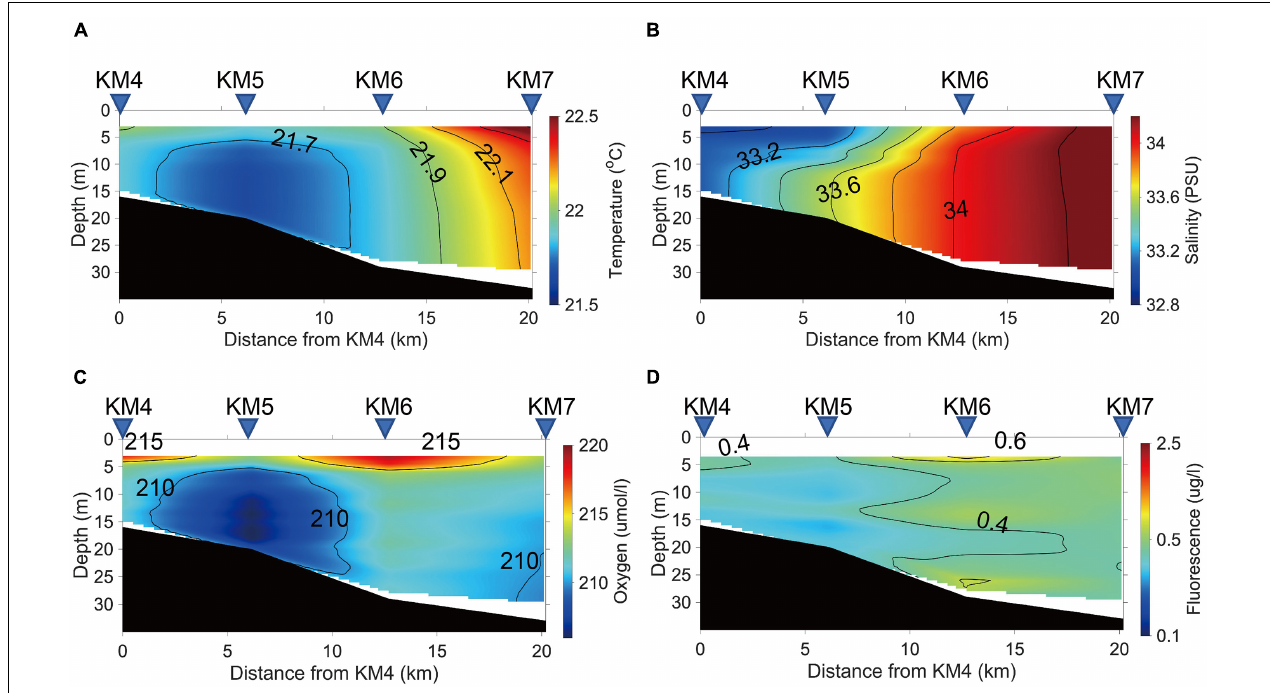
FIGURE 5 | 2-D structures along the transect between KM4 and KM7 of (A) temperature; (B) salinity; (C) DO; (D) fluorescence. The black area represents the sea floor.